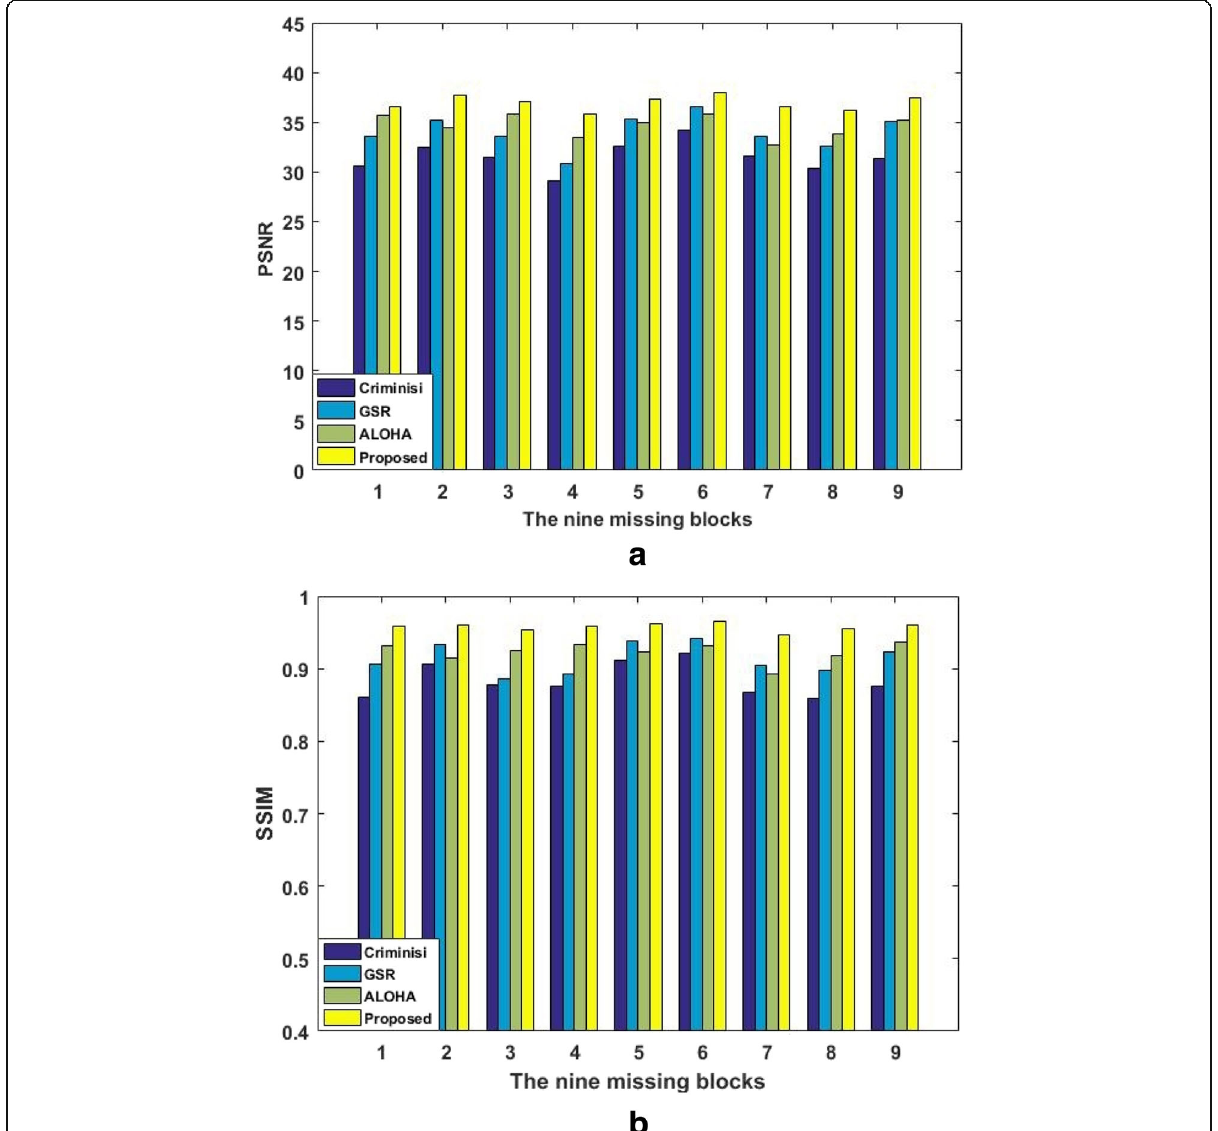
Fig. 8 Comparing results of the average PSNR and SSIM of test images with nine missing blocks. a The average PSNR of test images with nine missing blocks. b The average SSIM of test images with nine missing